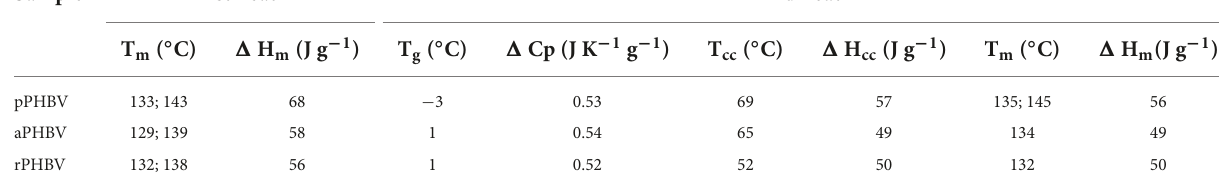
TABLE 4 Thermal properties of PHBV extracted from the wasted bread/seawater substrate with different methods ( Figure 1 ): pPHBV, obtained from the CHCl 3 :H 2 O separation and the precipitation with cold ethanol; rPHBV, obtained by the replacement of the CHCl 3 :H 2 O separation with repeated washing with water; aPHBV, obtained by the replacement of the CHCl 3 :H 2 O separation with repeated washing with water, but followed by solubilization in CHCl 3 and purification with cold